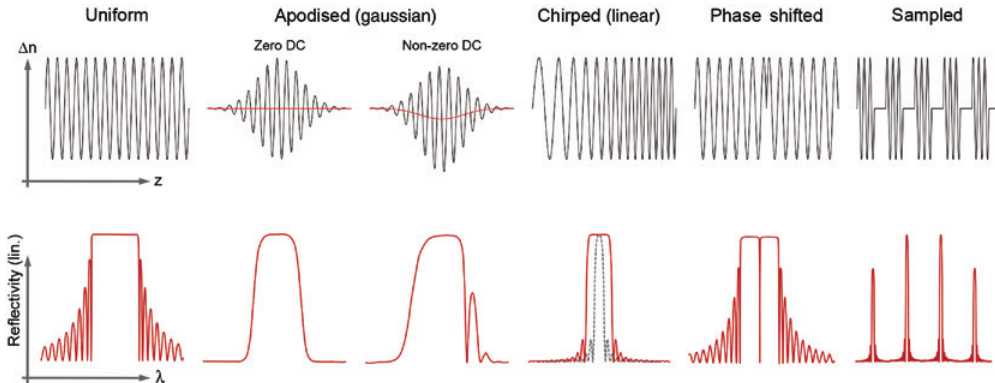
Figure 15: Illustrations of various refractive index modulations and their resulting reflection spectra. The red lines in the refractive index profiles for the Gaussian apodised gratings indicate the average refractive index